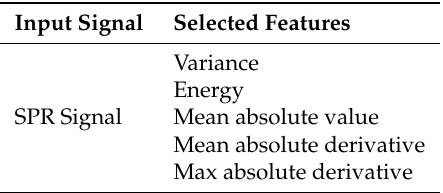
Table 1. The features used for the classification